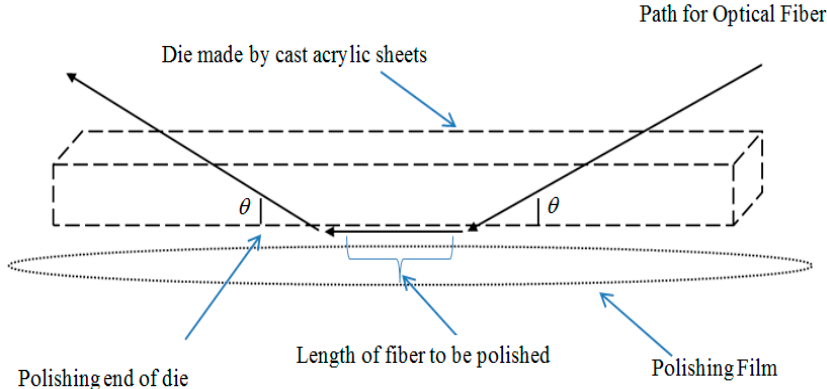
Figure 1. Conceptual illustration of the polishing system.